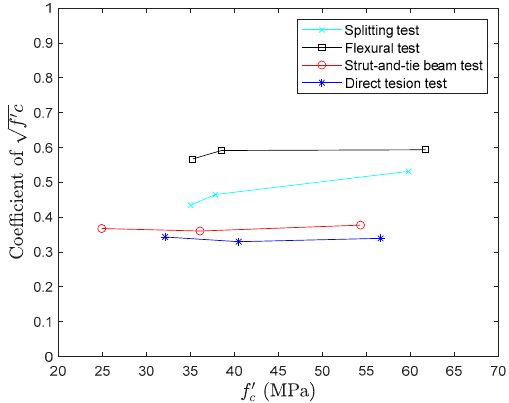
(cid:48) ffi c coe